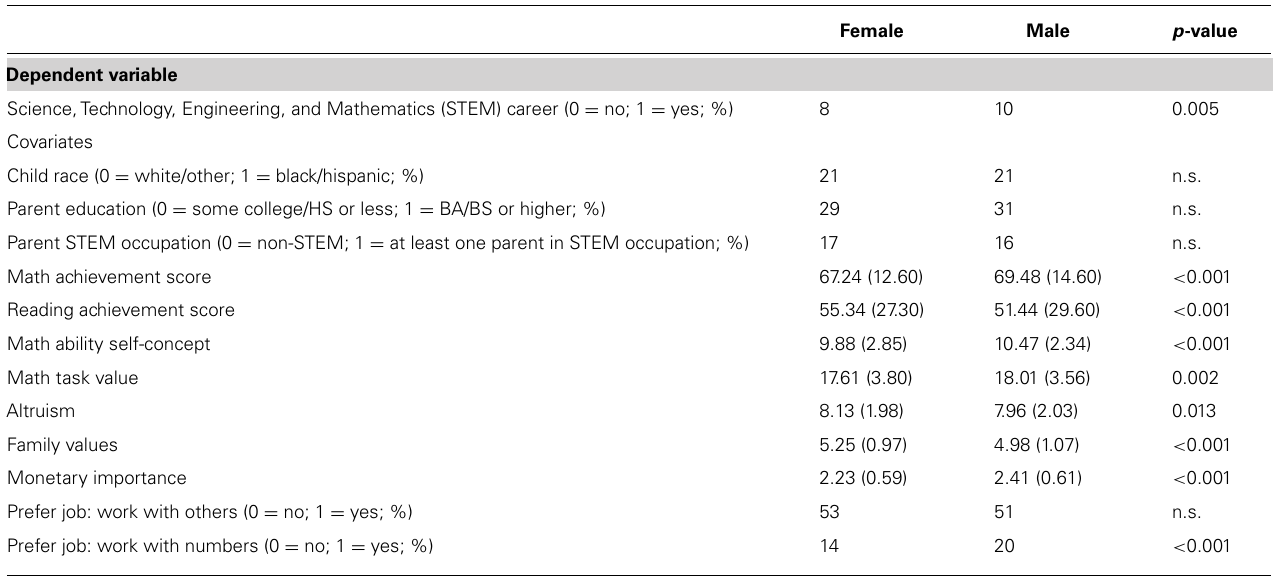
Table 1 | Descriptive statistics of the sample and tests of the difference between female and male ( N =